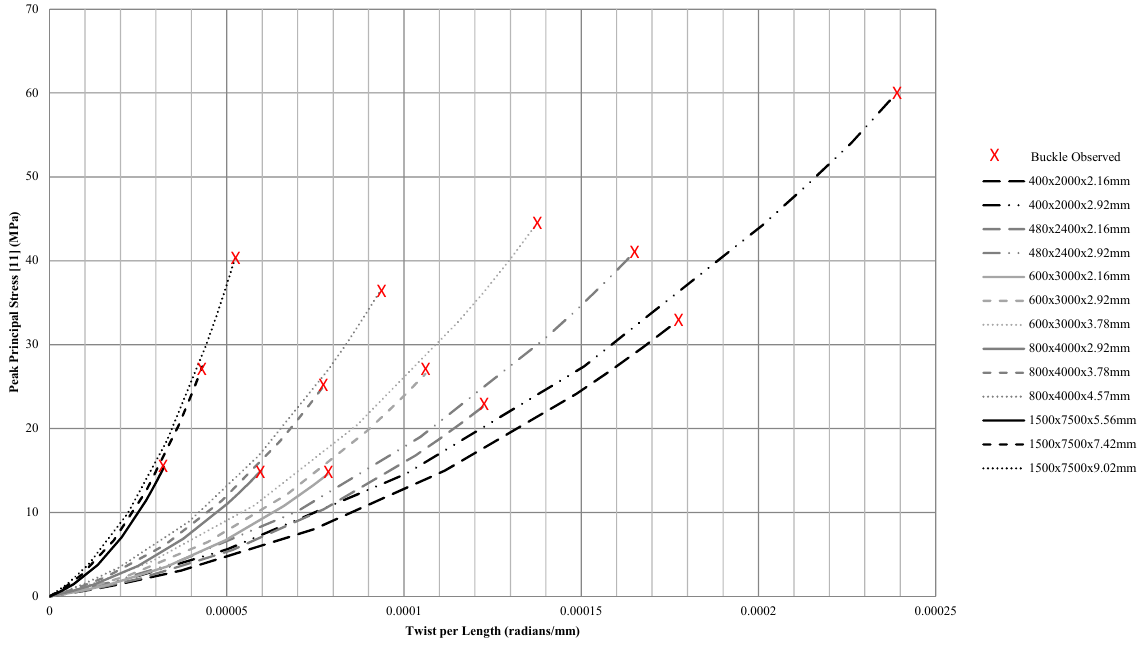
Fig. 13 Plate Stresses and Buckling from Twisting without Transverse Load (5:1 Aspect)